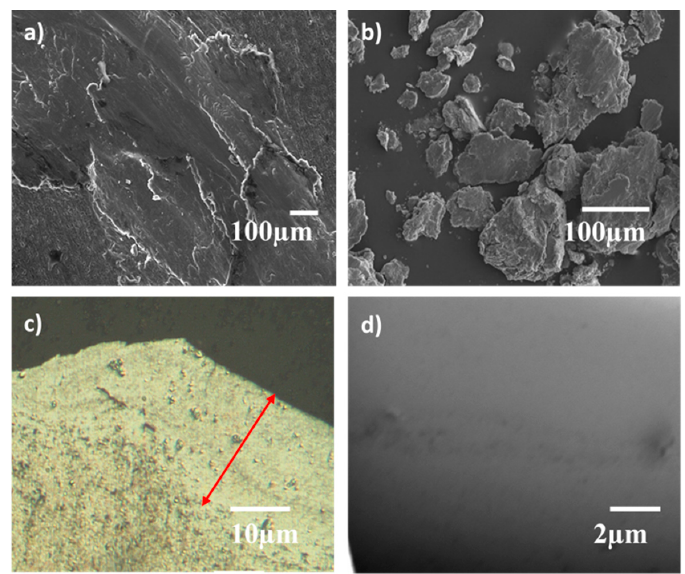
Figure 10. SEM images of the pure Al sample (200 °C): ( a ) wear track and ( b ) wear debris, ( c ) Optical micrograph of the sub-surface of the wear track, ( d ) FIB image of the sub-surface of the wear track.